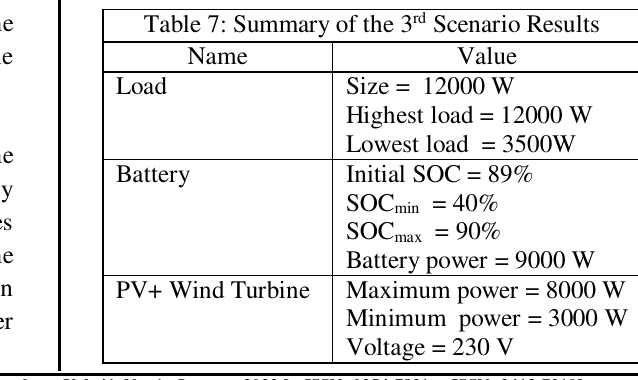
Table 7: Summary of the 3 rd Scenario